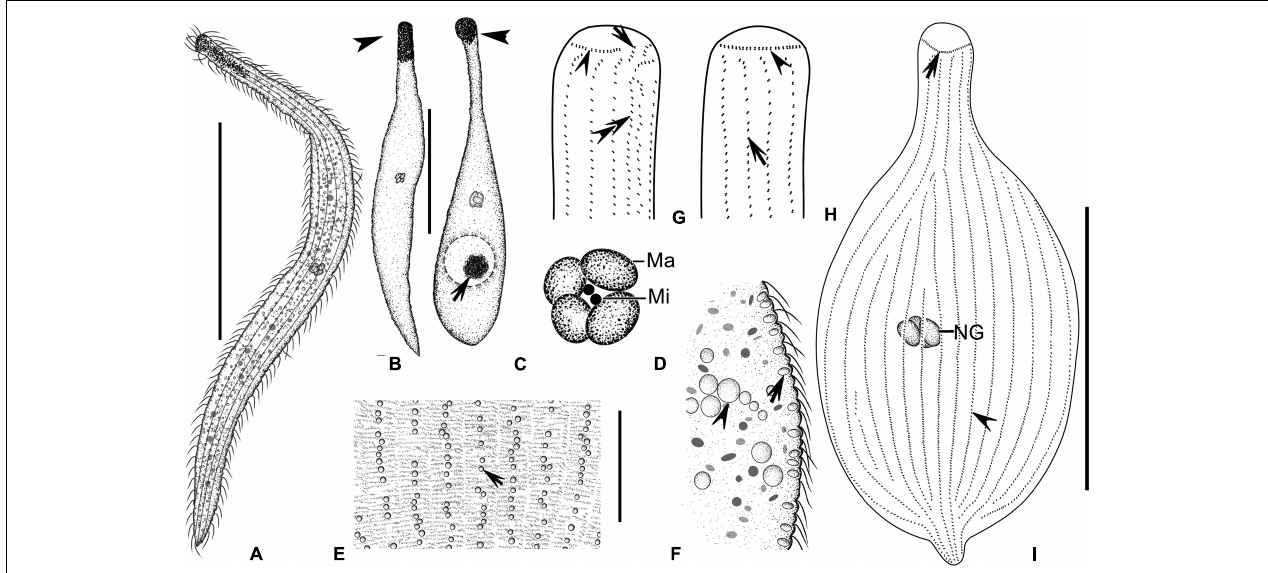
FIGURE 9 | (A–I) Tracheloraphis colubis in vivo (A–F) and after protargol staining (G–I) . (A,B) Typical individuals. Arrowhead showing the head of cell. (C) An extremely contracted cell, arrow showing algae in the food vacuole, arrowhead showing the head of cell. (D) Nuclear group. (E) Distribution of cortical granules between somatic kineties (arrow). (F) Lateral view, showing the elliptical cortical granules at the cell margin (arrow). Arrowhead showing the spherical inclusions. (G,H) . Detailed ciliature of left (G) and right (H) side of anterior body region. Arrowhead in (G) showing circumoral kinety, arrow showing brosse, double arrowheads showing bristle kinety. Arrowhead in (H) showing circumoral kinety, arrow showing somatic kinety. (I) Overview showing ciliary pattern. Arrow showing circumoral kinety, arrowhead showing somatic kinety. Ma, macronuclei; Mi, micronuclei; NG, nuclear group. Scale bars = 300 µ m (A) ; 200 µ m (B,C) ; 60 µ m (E) ; 100 µ m (I)